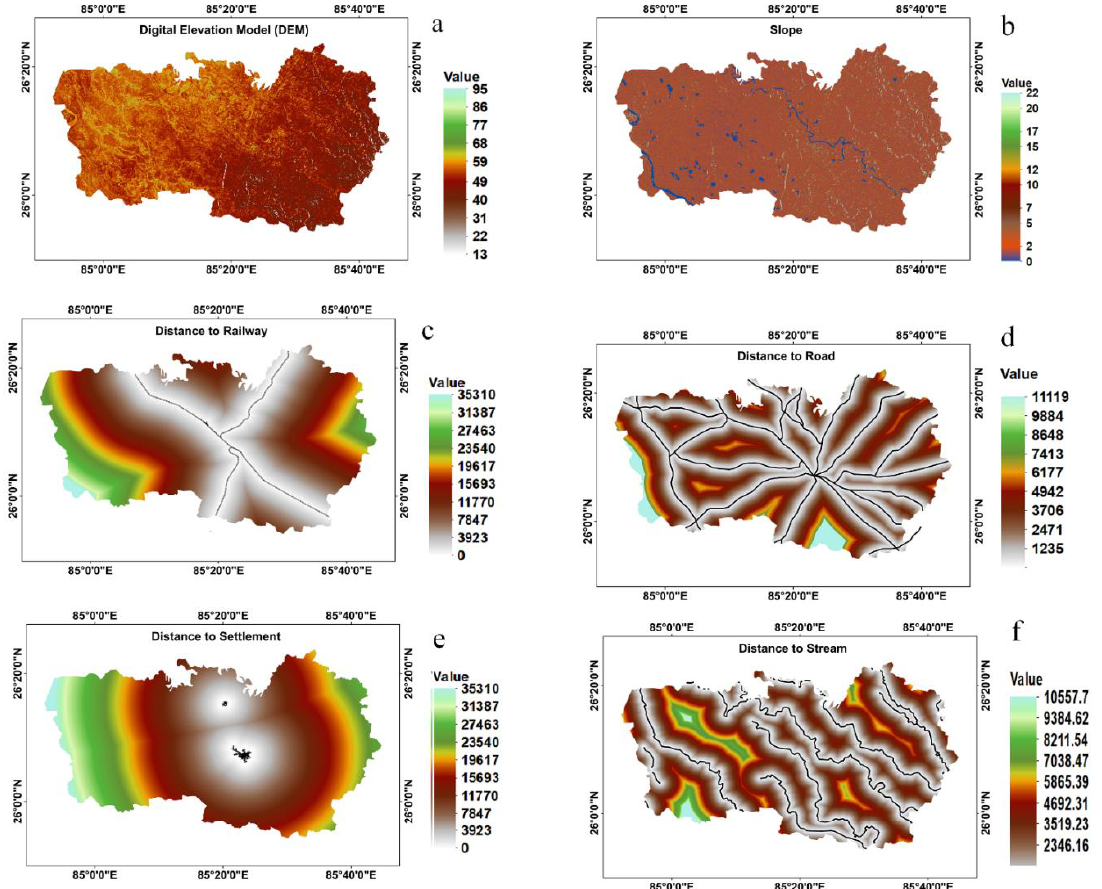
Figure 3. Different variables ( a – f ) used in this study.